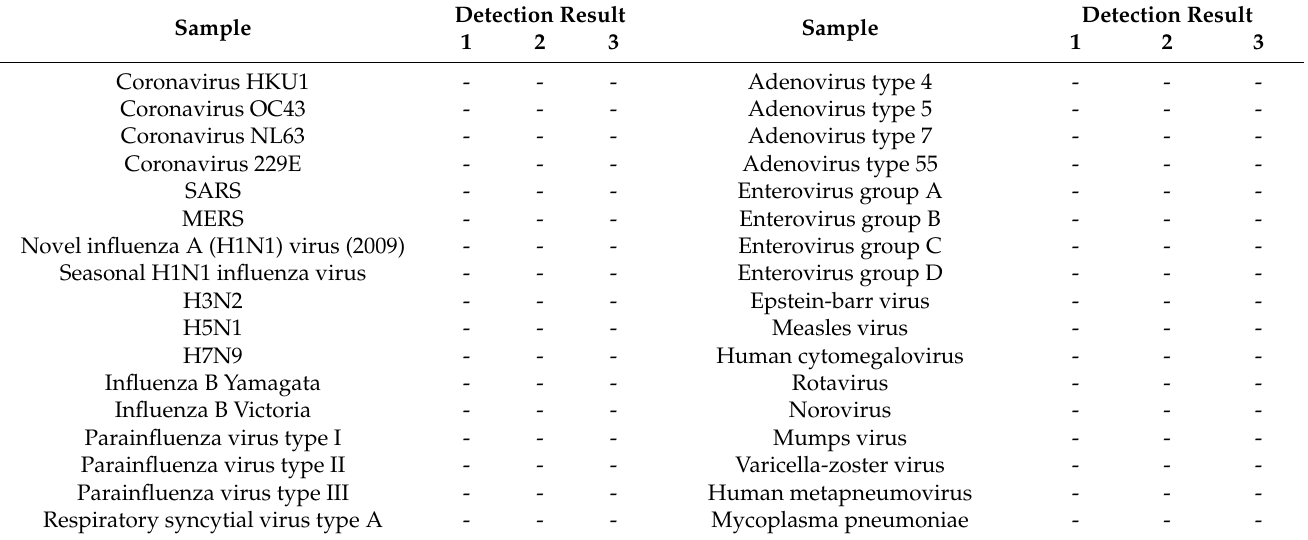
Table 5. Test strip cross-reaction validation results.